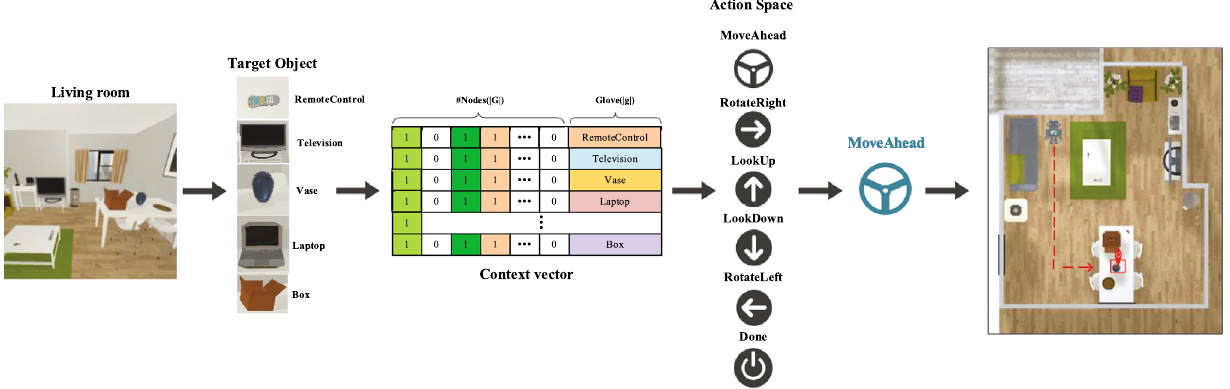
Fig. 1 Motivation of our method. We use the real label of objects to build up the context vector for all objects in our scene. An agent first detectsobjectsofinterestfromitsobservation.Contextvectorwillguide